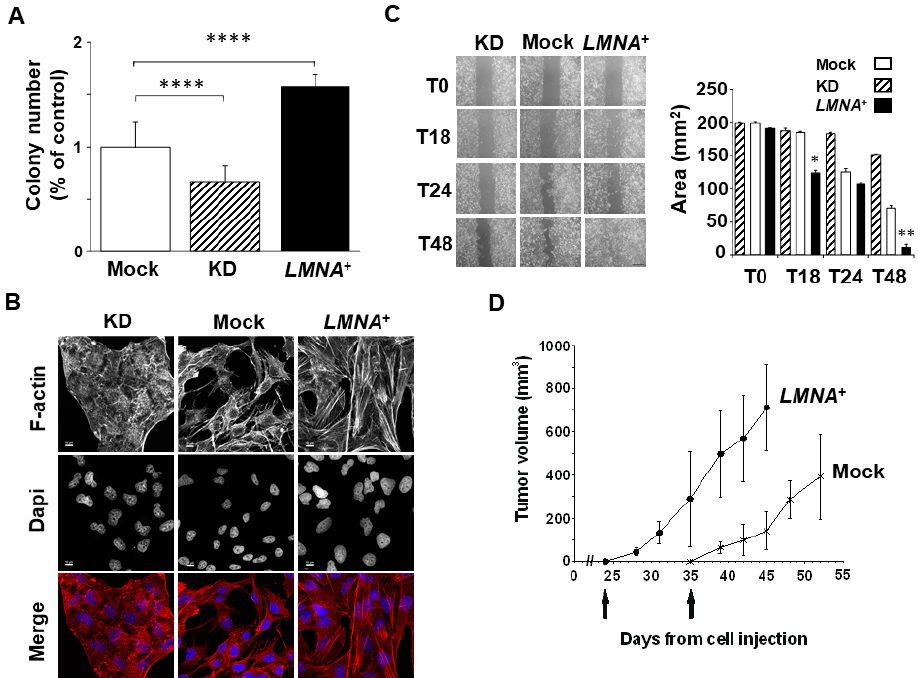
Figure 4. Overexpression of LMNA gene increases GBM aggressiveness and tumorigenesis. ( A ) Graphic quantification of colonies as analyzed by a colony-forming assay, showing that LMNA overexpression increased T98G cell colonies. The data are presented as the mean ± SEM of three independent experiments. Statistical significance: LMNA + vs mock cells **** p < 0.0001; KD vs mock cells **** p < 0.0001. ( B ) Representative confocal images of mock LMNA + and LMNA -KD (KD) cells. Red, F-actin; blue, DAPI. Scale bar: 10 microns. It is worthwhile to note that F-actin fibers are more organized and increased in number in LMNA + cell clone. ( C ) Cell migration as analyzed by a wound healing assay. LMNA expression has effect on migratory capacity as LMNA overexpression clearly increases wound healing at 48 h compared to the control cells. Left panel, representative images were captured with a phase-contrast microscope (20X) at 18, 24 and 48 h after wound. Scale bar (50 µ m) is the same for all the images and is shown in the right bottom image. Right panel, values of wound area (mm2) ± SEM (n = 3). mock cells (white), KD cells (dashed), LMNA + cells (black). Statistical significance: LMNA + vs Mock cells * p < 0.05, ** p < 0.01. ( D ) mock (*), LMNA + ( • ) and LMNA -KD cells were injected subcutaneously into the flanks of immunosuppressed mice at 10 6 cells/mouse in 200 µ L of Matrigel. When a tumor mass was evident, the tumor sizes were measured, and the tumor volumes were calculated using the following formula: (a × b 2 )/2, where a and b are the long and short diameters of the tumor, respectively. Injection of KD cells did not give rise to any tumour in the mouse up to 54 days post-injection, when also mice injected with mock cells were sacrificed. The mean ± SD tumor volumes are reported (n =